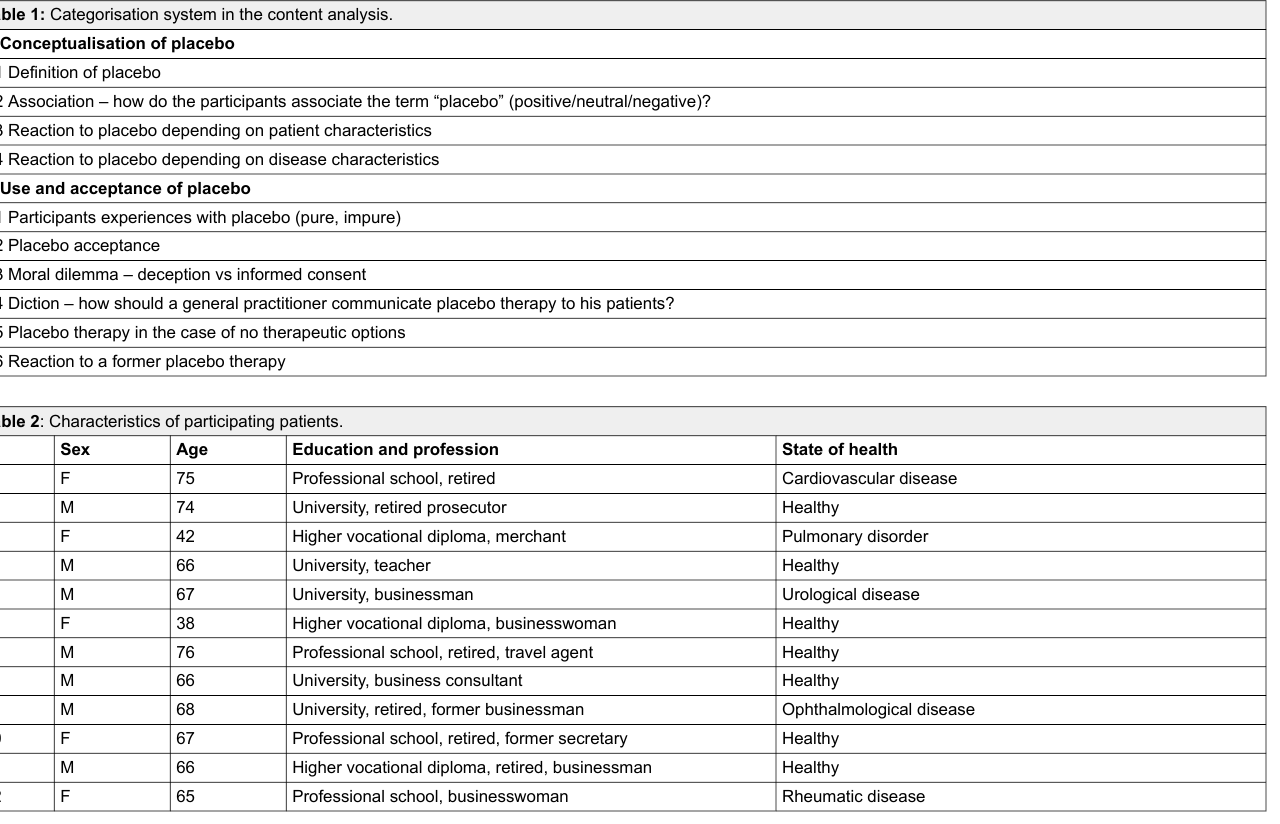
Table 1: Categorisation system in the content analysis.